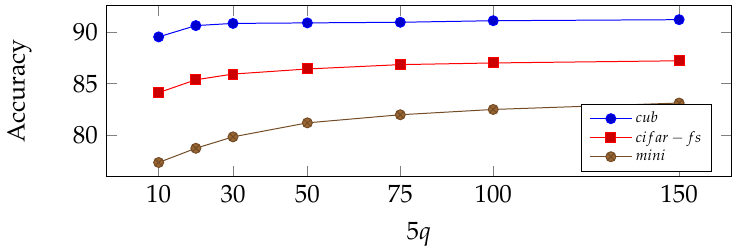
Figure 4. Accuracy of 5-way, 1-shot classification setting on miniImageNet, CUB and CIFAR-FS as a function of q .